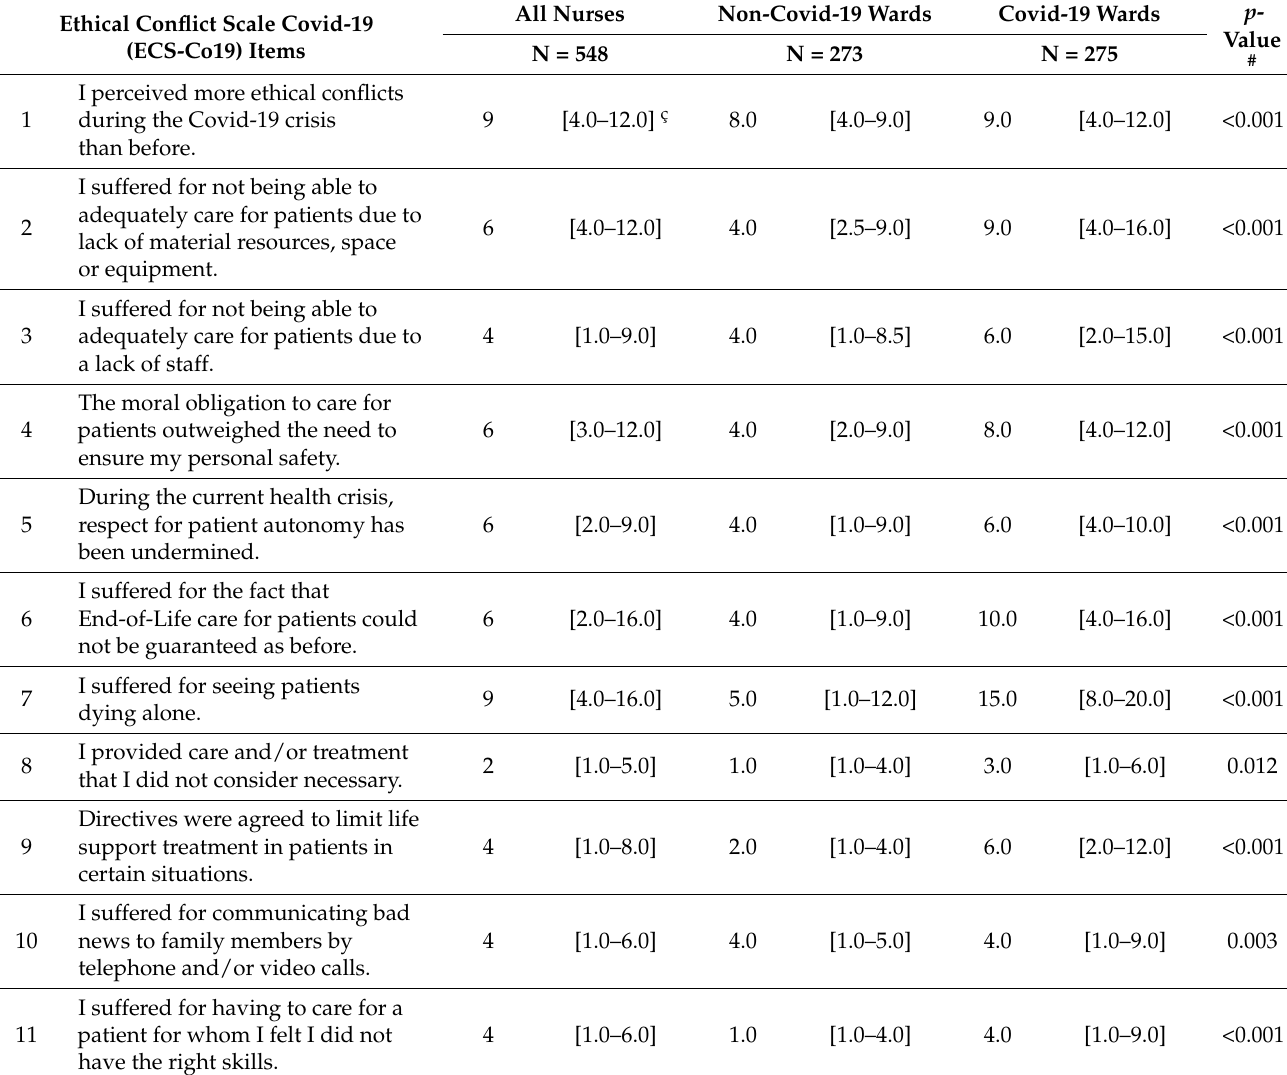
Table 2. Comparison of the ethical conflict score between Covid-19 and non-Covid-19